Question: Produce a descriptive caption suitable for publication.
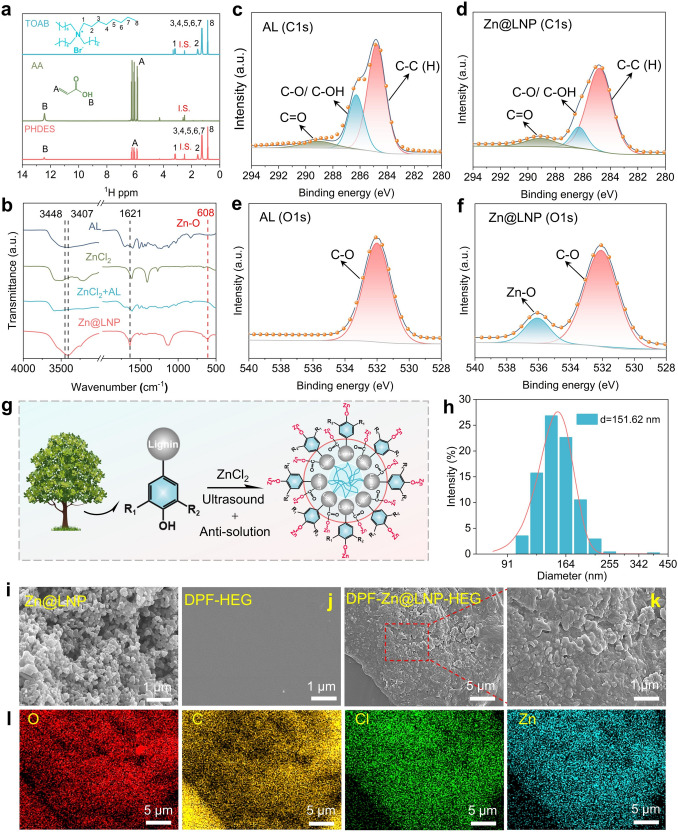
Answer: a 1 H NMR spectra of TOAB, AA, and PHDES. b FTIR spectra of AL, ZnCl 2 , ZnCl 2 + AL, and Zn@LNP. High-resolution XPS spectra of C 1 s c, d and O 1 s e, f regions for AL c, e and Zn@LNP d, f. g Schematic illustration of the Zn@LNP self-assembly process. h Particle size distributions of Zn@LNP. Cross-sectional SEM images of i Zn@LNP, j DPF-HEG, and k DPF-Zn@LNP-HEG, with l EDS elemental mappings of O, C, Cl, and Zn